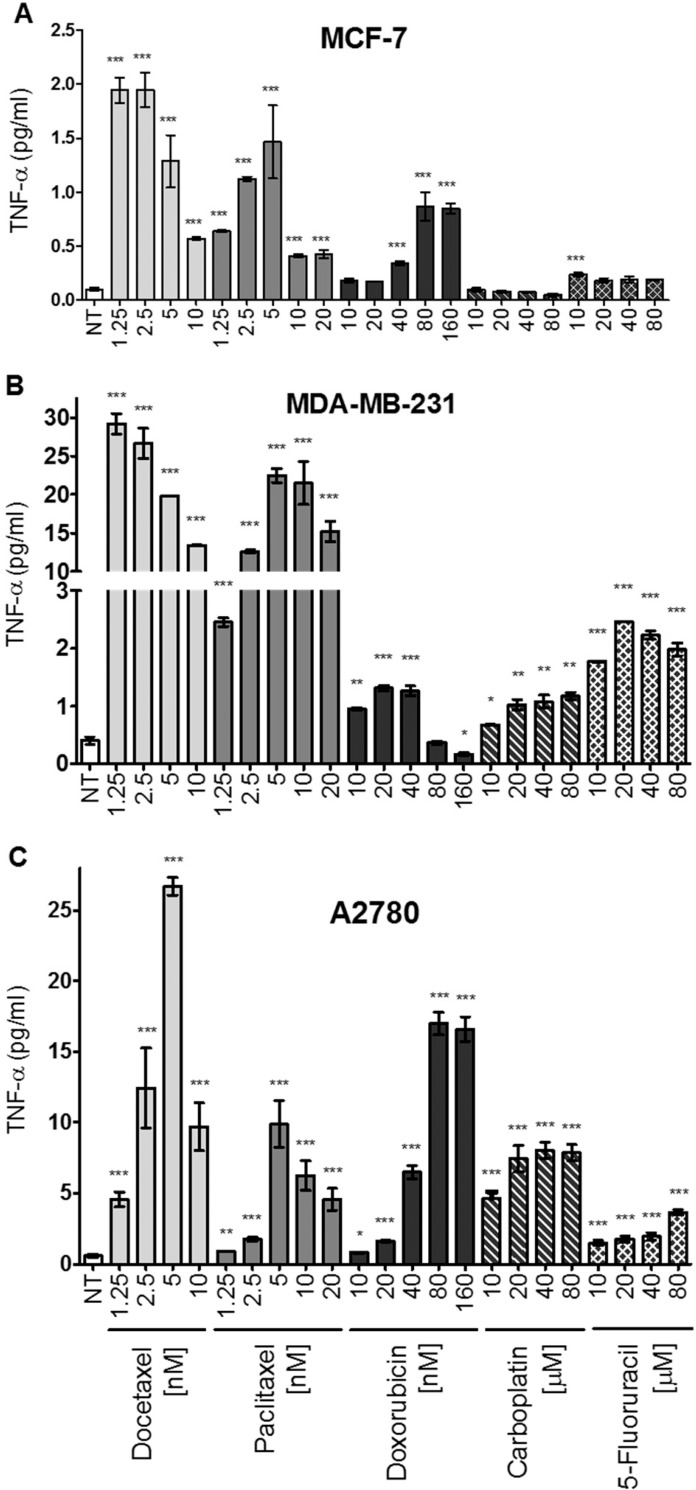
Increased TNF-α levels induced in select tumor cell lines by a variety of chemotherapeutic drugs.Soluble TNF-α levels in the media were measured by ELISA after 72 hr of treatment with either docetaxel, paclitaxel, doxorubicin, carboplatin, or 5-FU. Drug concentrations tested were based on IC50 values previously determined experimentally in MCF-7 cells. The data represents the mean of three replicates (+/-SEM). The significance of differences in TNF-α levels between treated and untreated cells was assessed using a two-tailed T-test; *** p<0.0001, **p<0.001, *p<0.05.